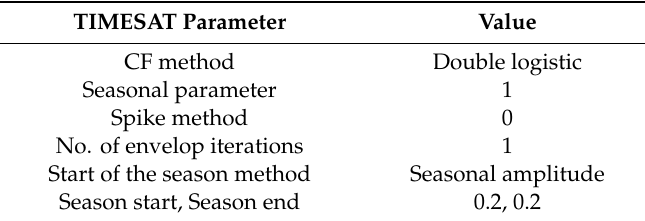
Table 2. Parameters setting in TIMESAT.